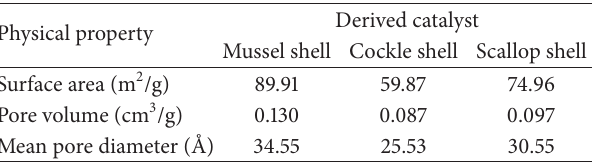
Table 2: The physical properties of waste shell-derived